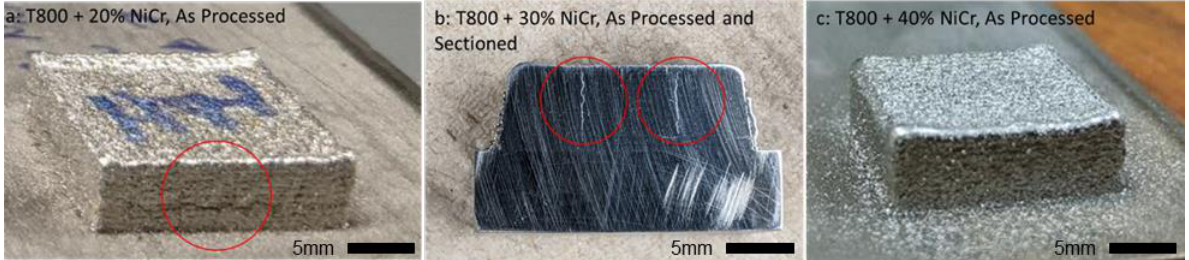
Figure 2. Structural integrity of T800 + NiCr alloy, as processed state. ( a ) Cracks seen after fabrication of T800 + 20% NiCr alloy; ( b ) Cracks only visible after sectioning in the T800 + 30% NiCr alloy; and ( c ) No structural defects in the T800 + 40% NiCr alloy. Each coupon is approximately 19 mm × 19 mm × 6 mm size as fabricated.